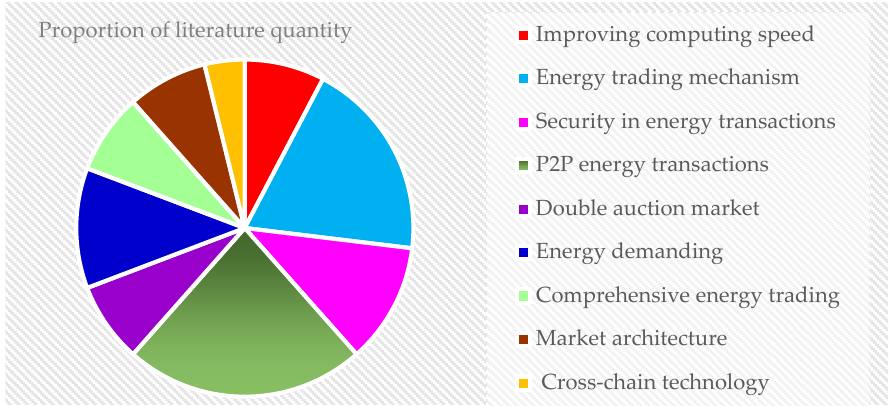
Figure 6. Research situation of blockchain in different fields of energy market.